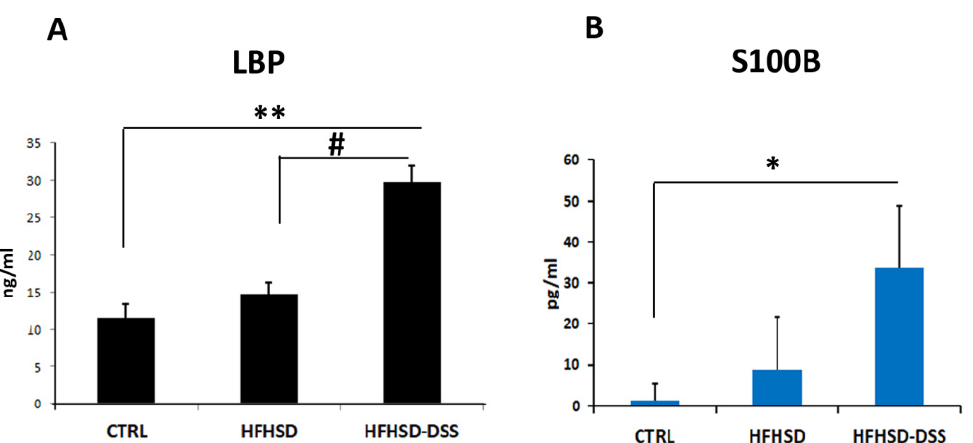
Figure 5. ( A ) Lipopolysaccharide binding protein (LBP) and ( B ) S100 β protein concentrations in serum of CTRL, HFHSD and in HFHSD-DSS mice, after 13 weeks of treatment; Statistical significance: * p < 0.05; ** p < 0.01; # p <